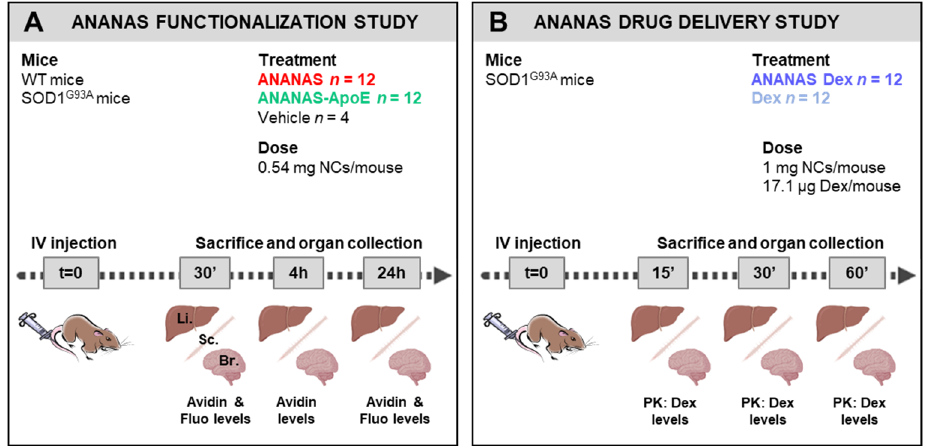
Figure 2. Experimental plan for NP functionalization and delivery study ( A ) WT and SOD1 G93A mice ( n = 12 mice per group) were intravenously (IV) treated with ANANAS, ANANAS-ApoE, or vehicle for ANANAS functionalization study. Liver (Li.), spinal cord (Sc.), and brain (Br.) were collected 30 min, 4 h and 24 h post treatment for biochemical and imaging analysis. ( B ) SOD1 G93A mice ( n = 12 mice per group) were intravenously (IV) treated with ANANAS-Dex or Dex for ANANAS drug delivery study. Organs were collected for PK measurements 15-, 30-, and 60-min post treatment.